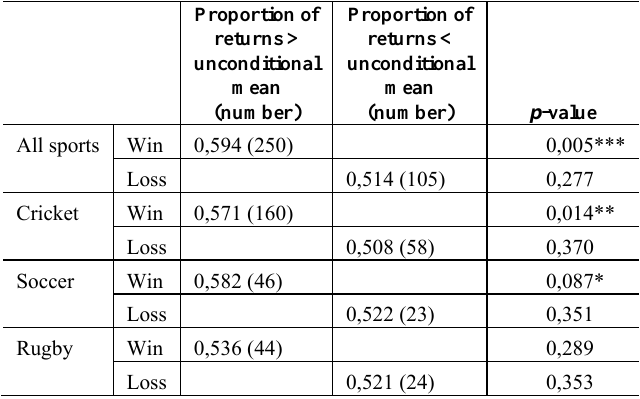
Table 2: Results of Z -tests for difference in proportions